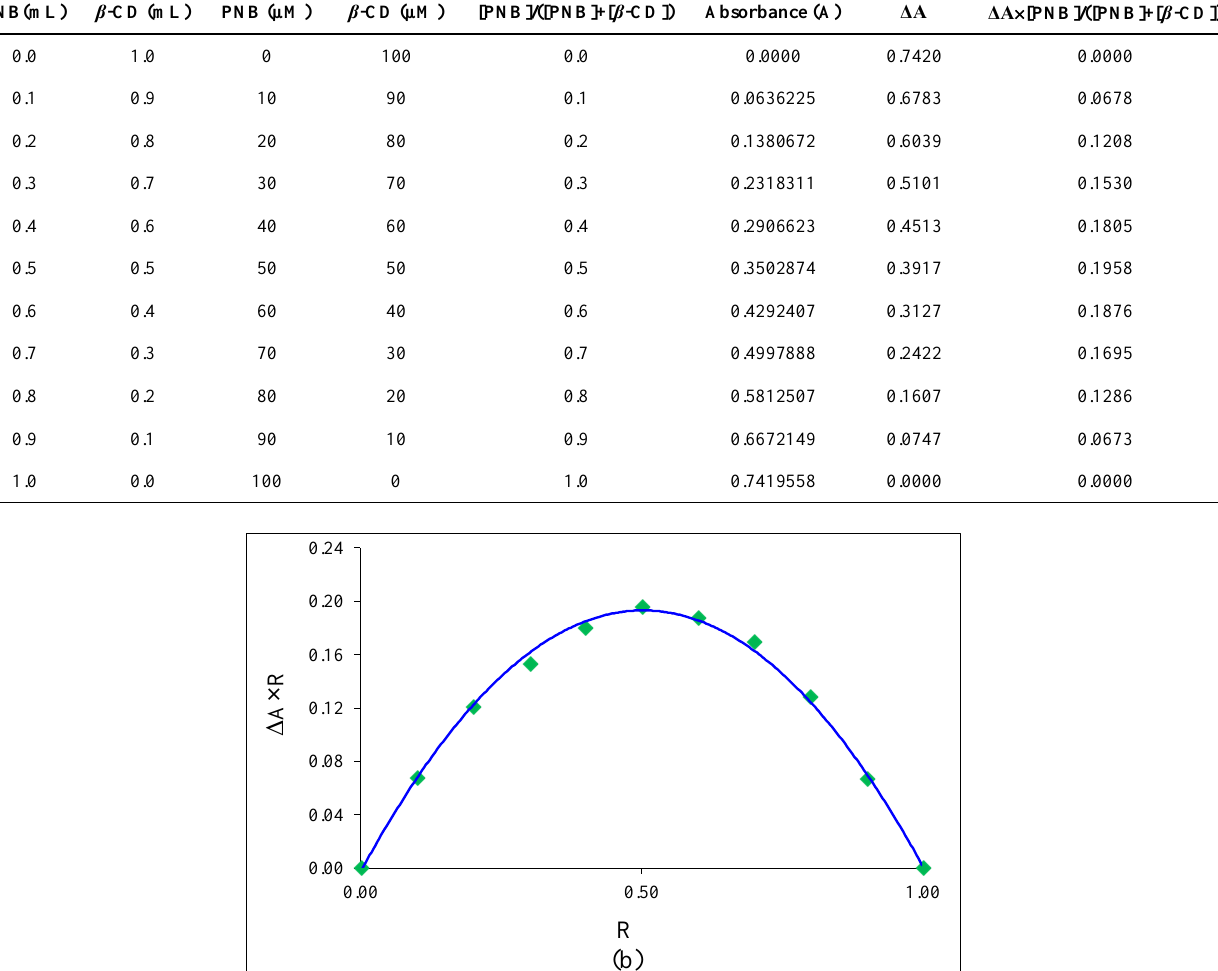
Figure 3. Job plot of (b) PB-β-CD system at λ max =243 nm at 298.15 K .R= [PNB]/([PnB] + [CD]) ,∆A=absorbance